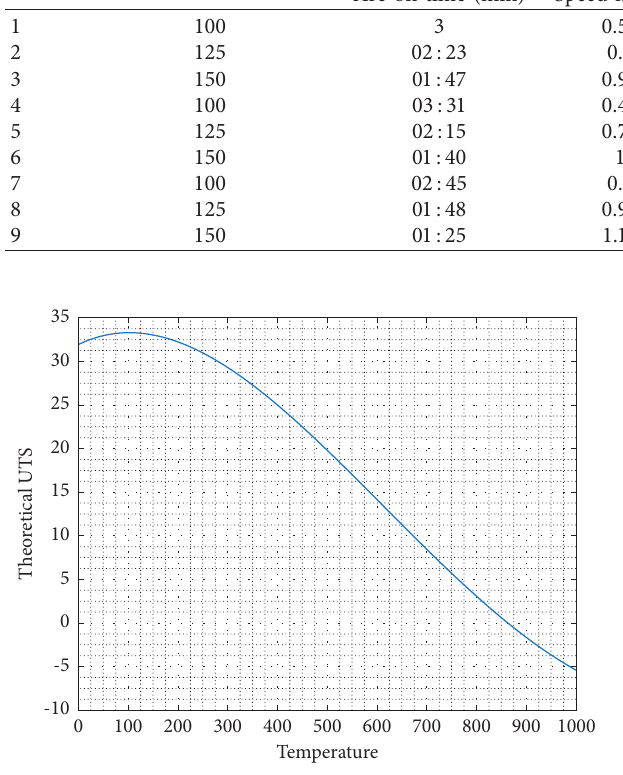
Figure 6: Theoretical UTS v/s temperature for similar materials.